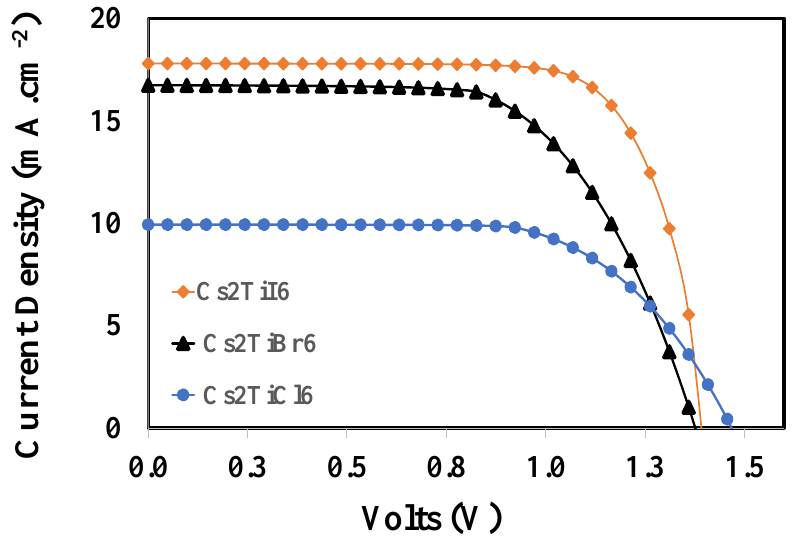
Figure 8. The overall photovoltaic response of the optimized solar perovskite devices. Table 4. The photovoltaics parameters’ open-circuit voltage, short-circuit current, fill-factor, and power-conversion efficiency of the fully optimized devices (a) Cs 2 TiI 6 , (b) Cs 2 TiBr 6 , and (c) Cs 2 TiCl 6 , respectively. Devices Open-Circuit Voltage Short-Circuit Current Fill-Factor